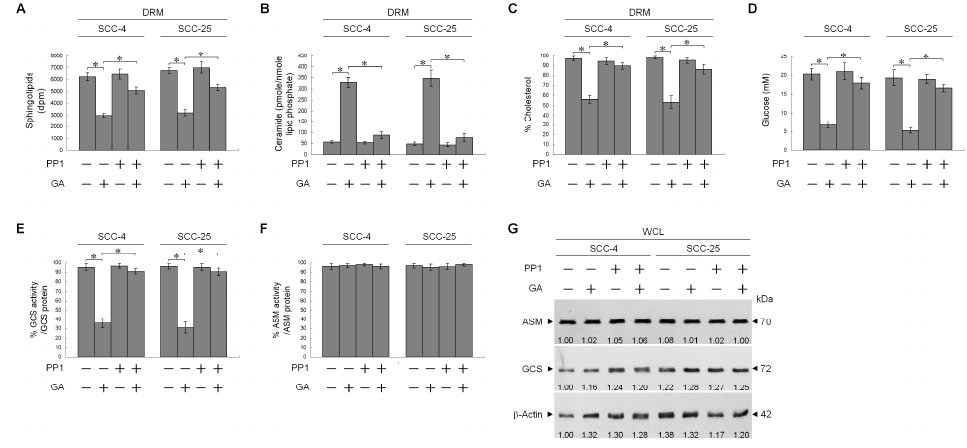
Figure 6. Gallic acid (GA)-induced cellular-Src (c-Src) activity confers perturbation of the lipid homeostasis of lipid raft membranes by suppressing glucosylceramide synthase (GCS) activity. Tongue squamous carcinoma (TSC) cells were treated with either vehicle ( − ), GA (20 µ M), 1-(1,1-dimethylethyl)-3-(4-methylphenyl)-1H-pyrazolo[3,4-d]pyrimidin-4-amin (PP1) (6 µ M), or GA